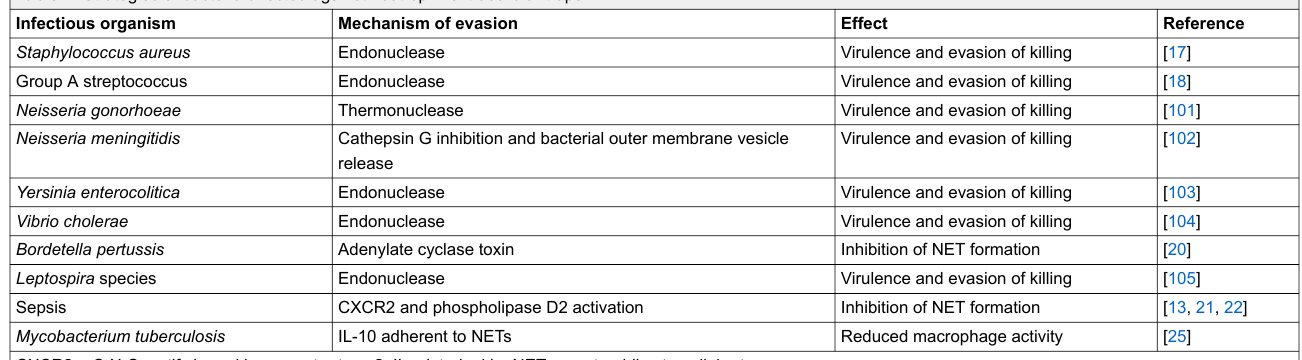
Table 1: Strategies of bacteria directed against neutrophil extracellular